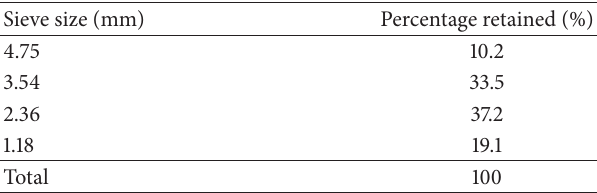
Table 3: Grading of OPS